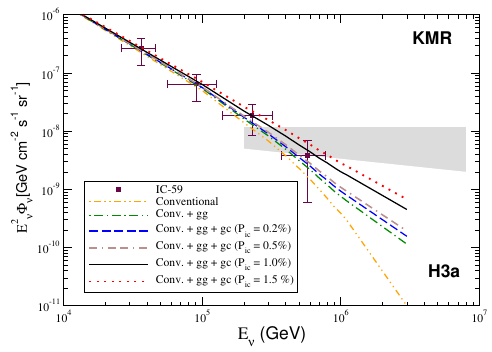
Figure 2: Comparison between our predictions and the experimental IceCube data [ 1 ] for the atmospheric ν µ flux for the KMR